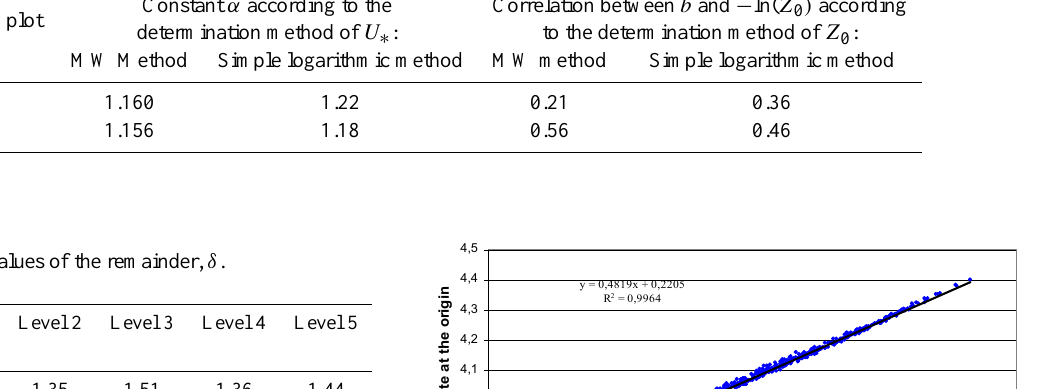
Table 5. Values of α and correlation between “ b ” and Z 0 , according to the determination methods of U ∗ and Z 0 . Constant α according to the Correlation between b and − ln( Z 0 ) according Figure 5: Variance normalized by the square of the friction velocity as a function of the Considered plot height logarithm (Plot RT, 25 July 1997)